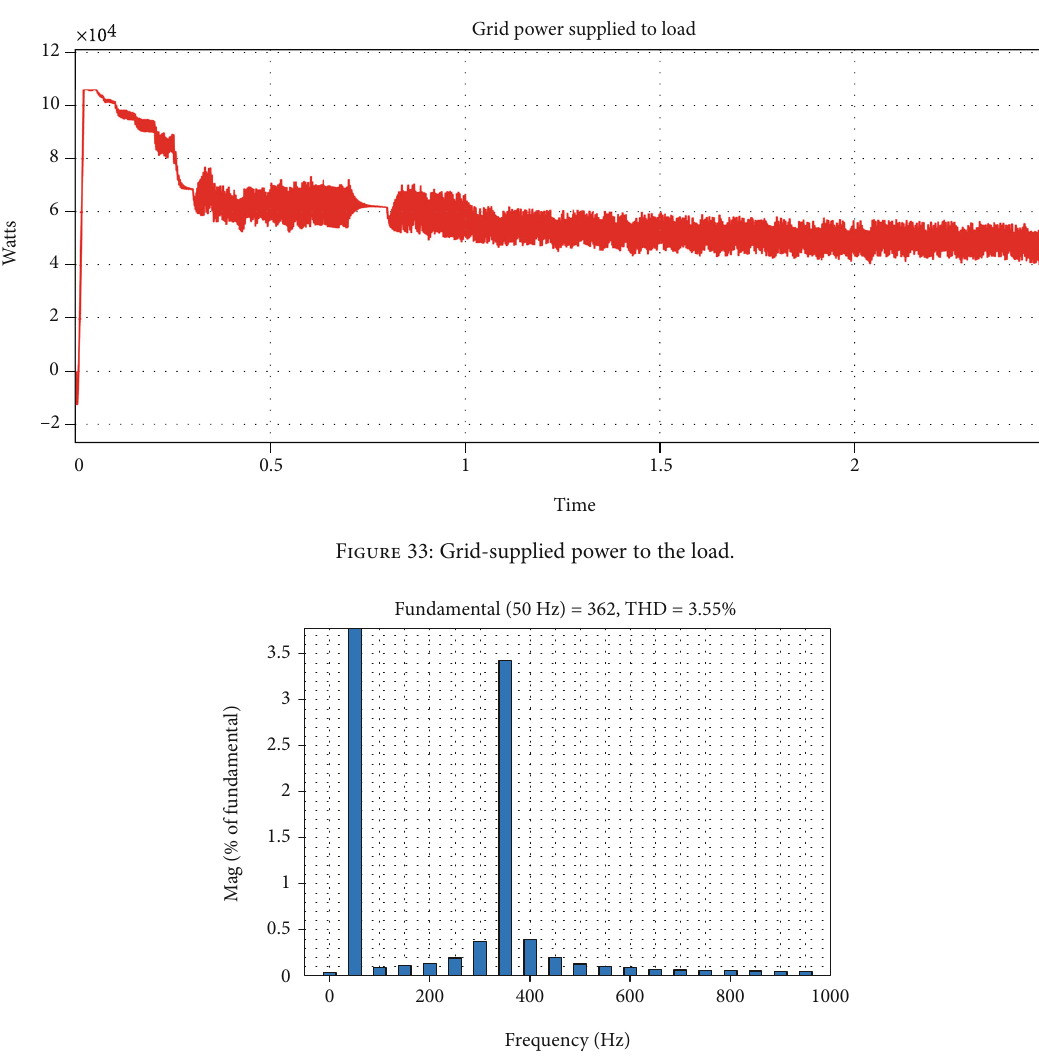
Figure 34: THD values for PV system